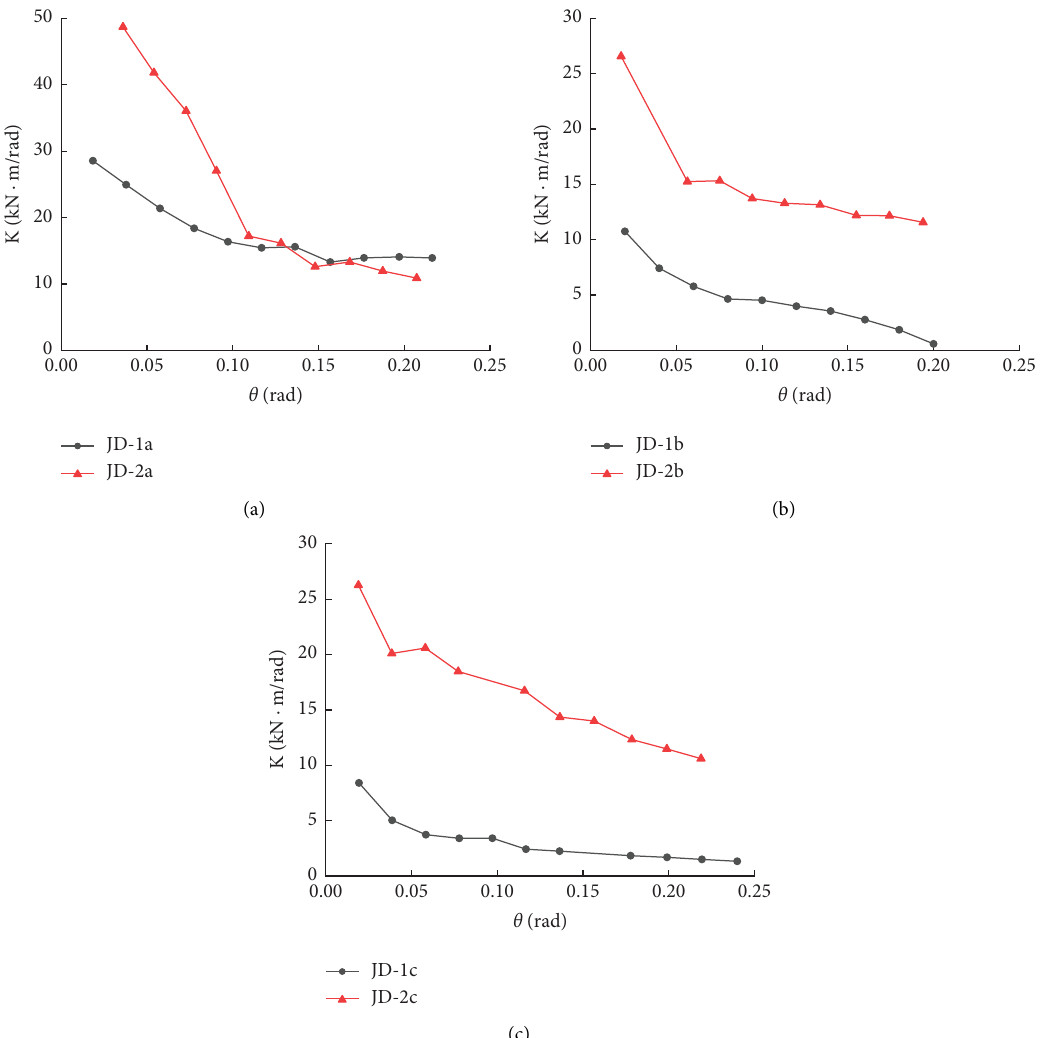
Table 7: Comparison of stifness before and after reinforcement.